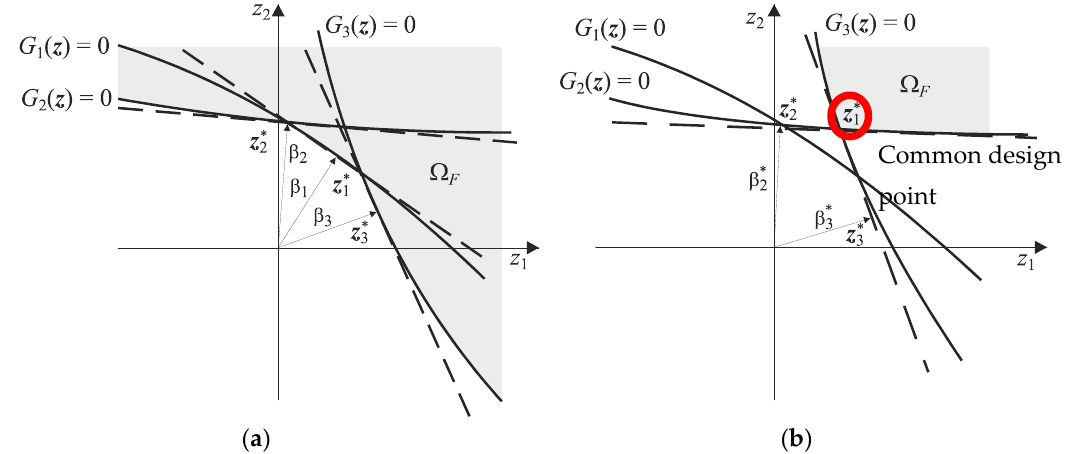
Figure 2. Linearization of limit state functions for: ( a ) series system, ( b ) parallel system.